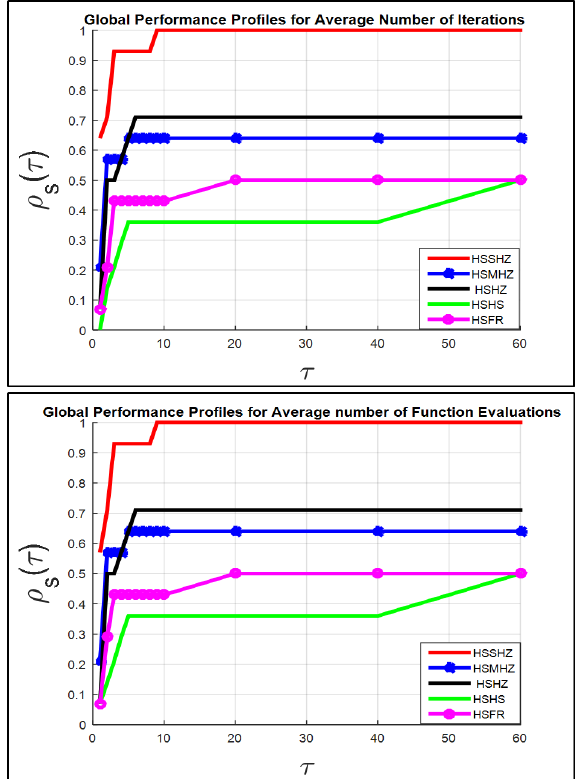
Figure 8. Plotting the results of the terms itr.a and FEs.a for 5